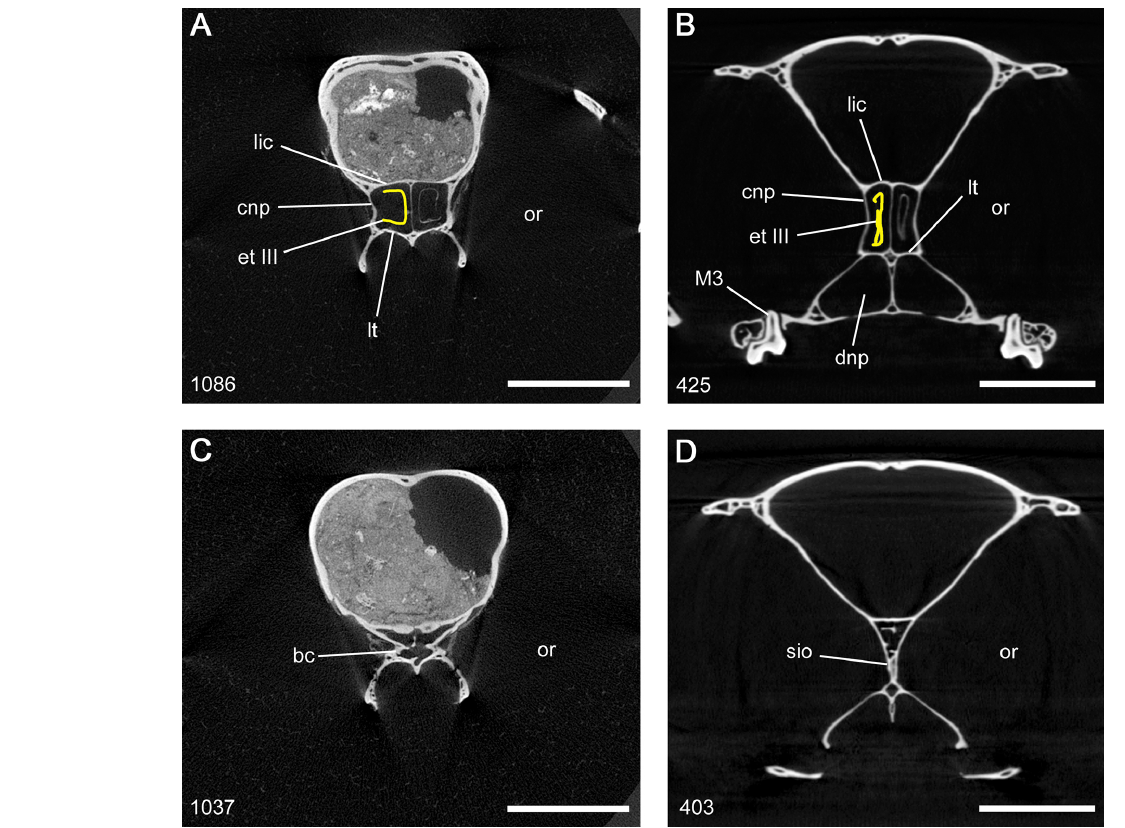
Figure 15. µCT cross-section images of the cupula nasi posterior of the adult rostrum and the anterior orbitotemporal region from anterior to posterior of (a , c) Ptilocercus lowii (ZMB 3992) and (b , d) Tupaia sp. (collection W. Maier). Numbers in figures refer to number of original µCT slices. Abbreviations: bc, basicranium; cnp, cupula nasi posterior; dnp, ductus nasopharyngeus; et III, ethmoturbinal III; lic, lamina infracribrosa; lt, lamina terminalis; M3, upper molar 3; or, orbit; sio, septum interorbitale. Scale bars equal